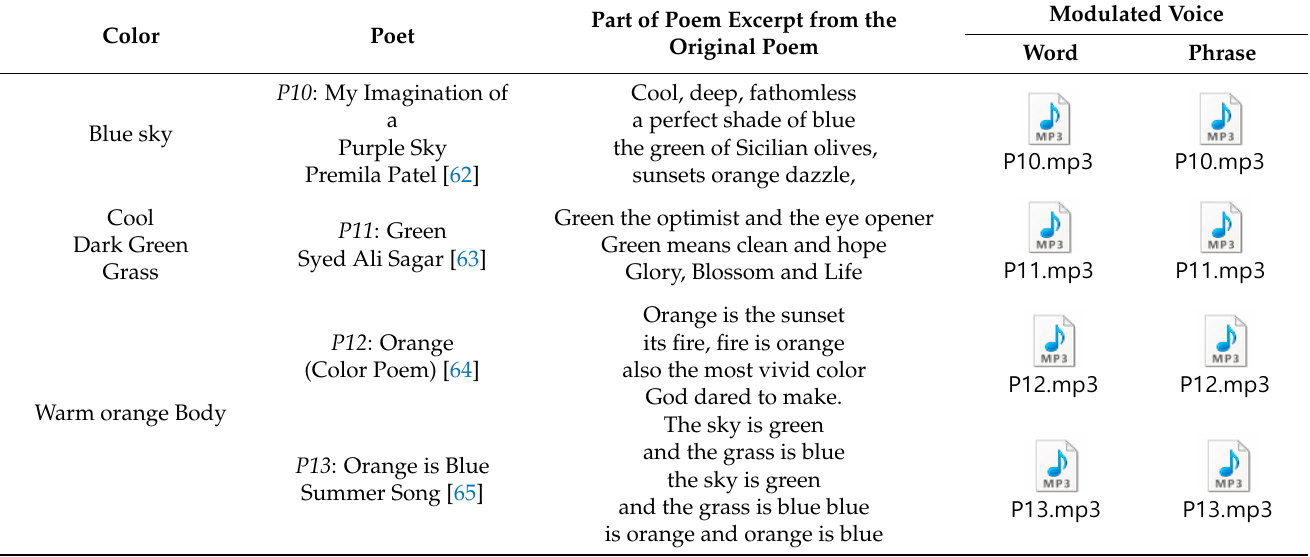
Table 7. Poetry for representing colors in Henry Matisse’s “Dance”.